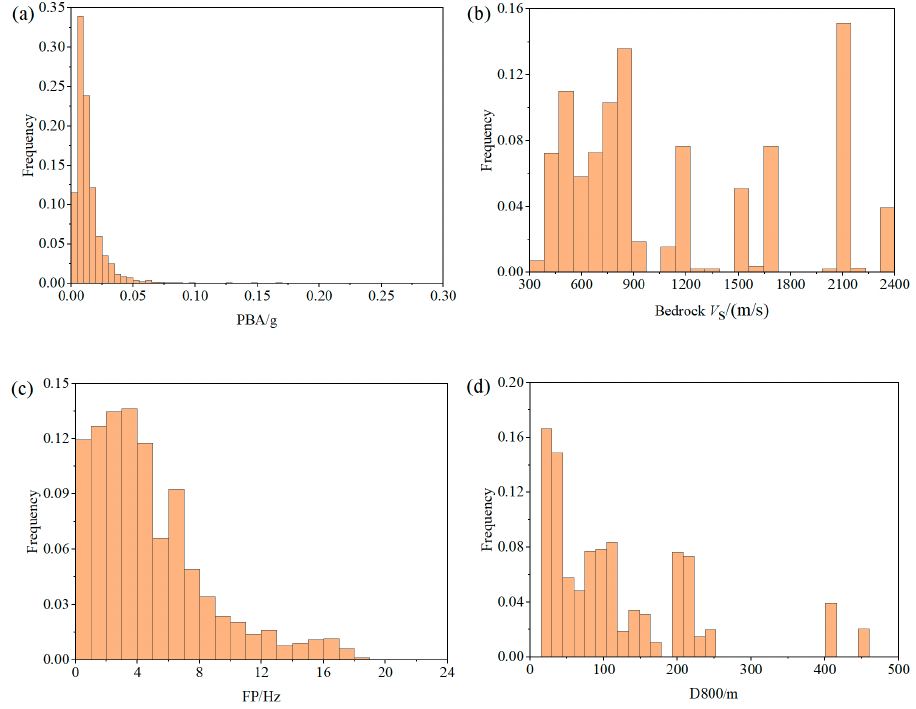
Figure 4. The data distribution for ( a ) PBA, ( b ) Bedrock V s , ( c ) FP, and ( d ) D800. The correlation matrix of the four input features is shown in Figure 5. This matrix is symmetrical, with the same correlation shown above the main diagonal being a mirror image of the values below the main diagonal. The number in the correlation matrix and the color of the rectangle represent the strength of the correlation. The correlation between the four input features is